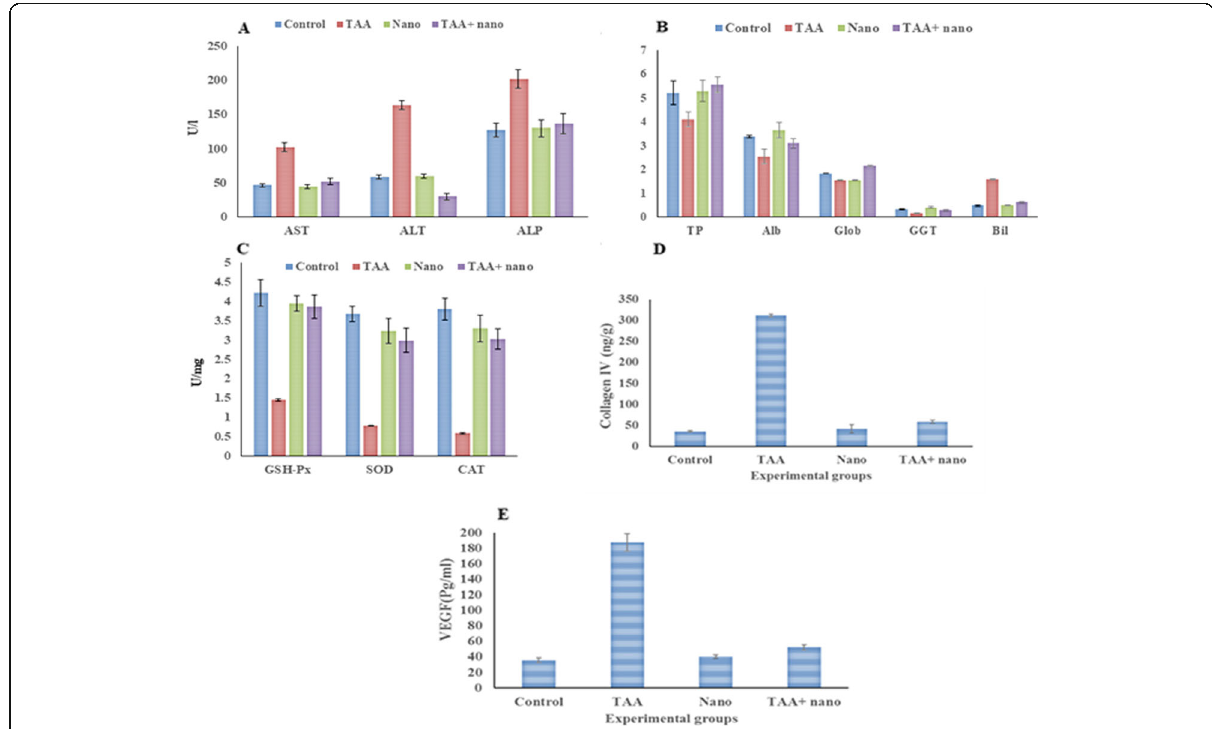
Fig. 4 a Effect of Ag-BSEPS on the liver functions in fibrotic rats. ALT, AST, and ALP before and after treatment with Ag-BSEPS. One-way of variance analysis (ANOVA) followed by the Tukey – Kramer multiple range comparison tests. Data shown are mean ± S.E.M. and represent the significance of difference, p < 0.05. b Effect of Ag-BSEPS on the total protein (TP), albumin (Alb), globulin (Glob), GGT, and bilirubin (Bil) in fibrotic and treated rats. One-way ANOVA followed by the Tukey – Kramer multiple range comparison tests. Data shown are mean ± S.E.M. and represent the significance of difference, p < 0.05. c Effect of Ag-BSEPS on the liver antioxidant enzymes in fibrotic and treated rats. One-way ANOVA followed by the Tukey – Kramer multiple range comparison tests. Data shown are mean ± S.E.M. and represent the significance of difference, p < 0.05. d Effect of Ag-BSEPS on the collagen IV in fibrotic rats. One-way ANOVA followed by the Tukey – Kramer multiple range comparison tests. Data shown are mean ± S.E.M. and represent the significance of difference, p < 0.05. e Effect of Ag-BSEPS on the VEGF in fibrotic rats. One-way ANOVA followed by the Tukey – Kramer multiple range comparison tests. Data shown are mean ± S.E.M. and represent the significance of difference, p <